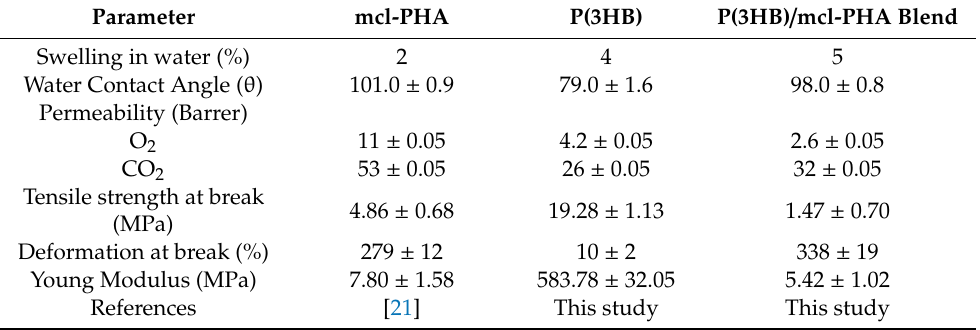
Figure 6. Images of the films surface layer ( left ) and cross section ( right ) assessed by scanning electron microscopy using an energy dispersive spectroscope (SEM-EDS): mcl-PHA ( A ), P(3HB) ( B ), and P(3HB) / mcl-PHA blend ( C ) films obtained by solution casting and solvent evaporation (images A1 and A2 are reproduced with permission from Rebocho et al. [21]). Table 3. Characteristics of the films prepared from mcl-PHA, P(3HB), and P(3HB) / mcl-PHA blend: water contact angles, permeability to gases, and mechanical